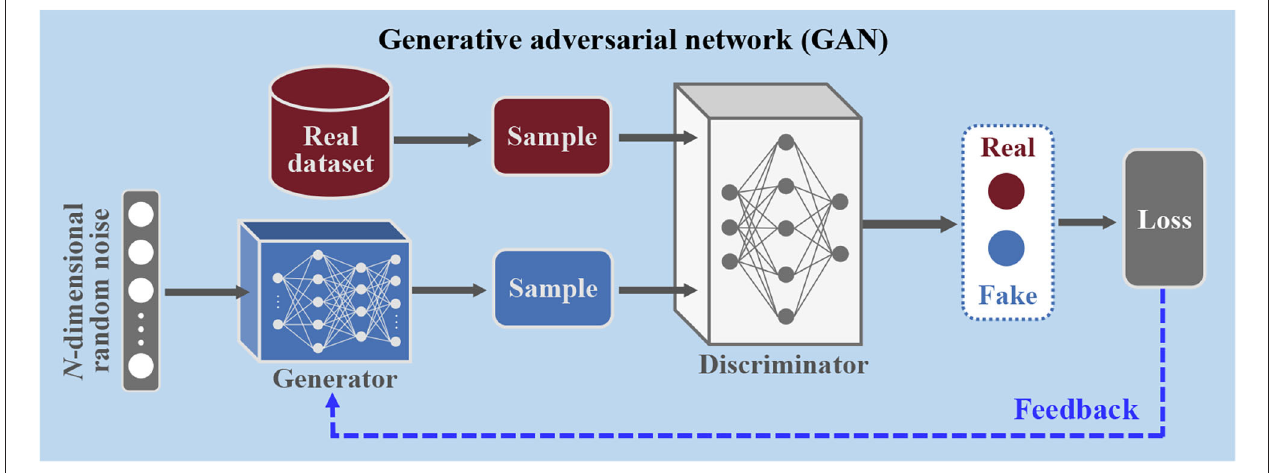
FIGURE 5 | Schematic of the generative adversarial network, consisting of two neural networks: a generator and a discriminator. The generator is used to produce the approximated samples from the N -dimensional random noise. The discriminator is used to identify whether a sample is real or fake. These two networks compete with each other and are optimized gradually to realize data